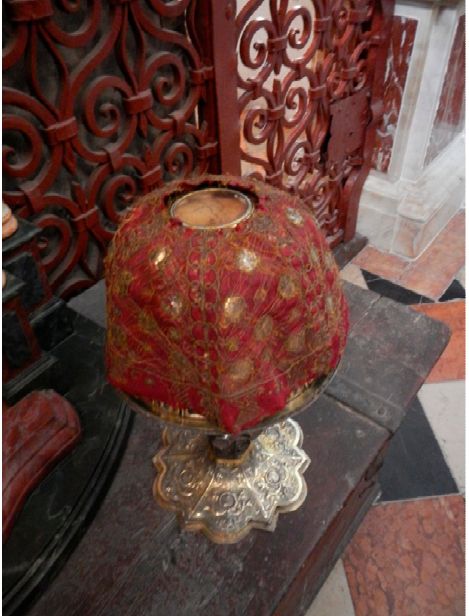
Figure 5. Cloth for the “Glorious Head”, 17th century, Cathedral of Saint Tryphon, Kotor, photo by author.